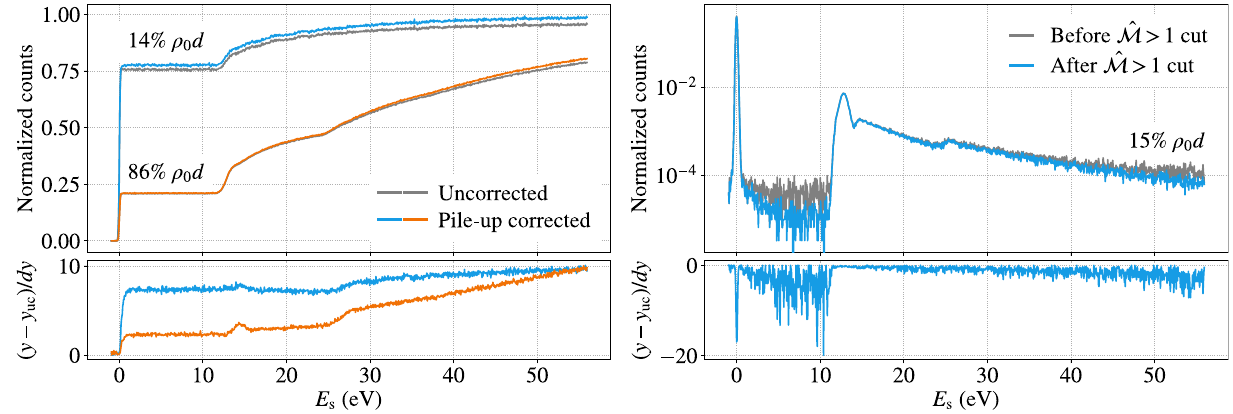
Fig. 6 Left:Selectionofmeasuredresponsefunctionsinintegralmode before (grey line) and after (colored line) pile-up correction. The cor- rection removes spectral shape distortions up to ten times larger than thestatisticaluncertainties.Right:Differentialresponsefunctionbefore and after applying the ˆ M > 1 cut. The cut reduces the background